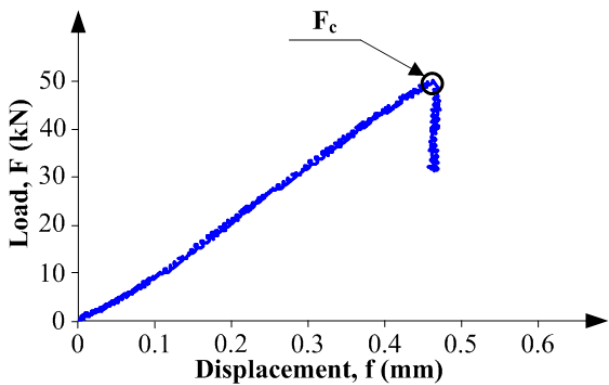
Figure 8. An example graph of load-displacement relationship obtained in the tests at mode II fracture.